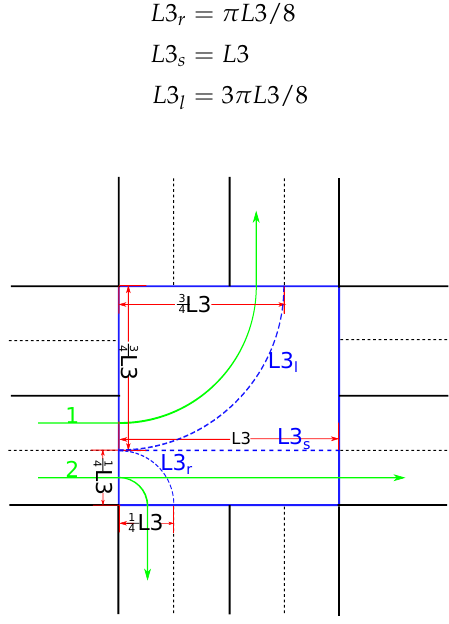
Figure 4. Various lengths of passing the intersection in different